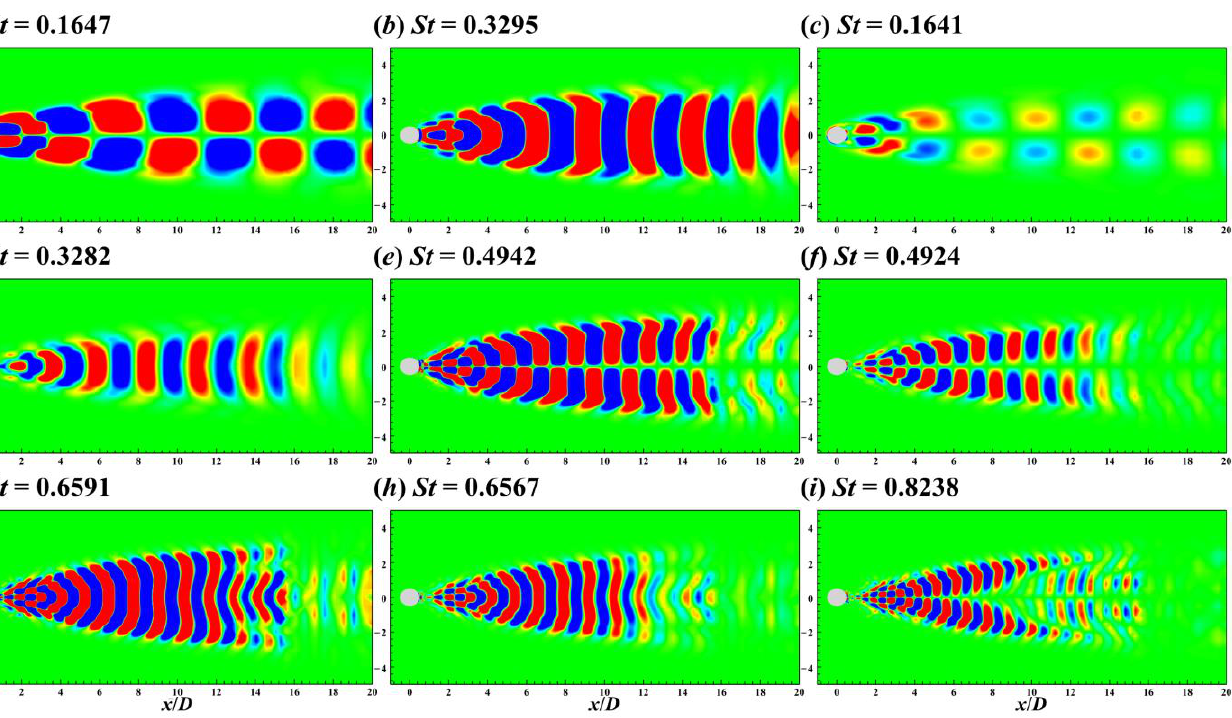
Figure 18. Contours of the St = 0.1647 ( a ), 0.3295 ( b ), 0.1641 ( c ), 0.3282 ( d ), 0.4942 ( e ), 0.4924 ( f ), 0.6591 ( g ), 0.6567 ( h ), and 0.8238 ( i ) DMD modes on the xz plane for the flow around the single cylinder.